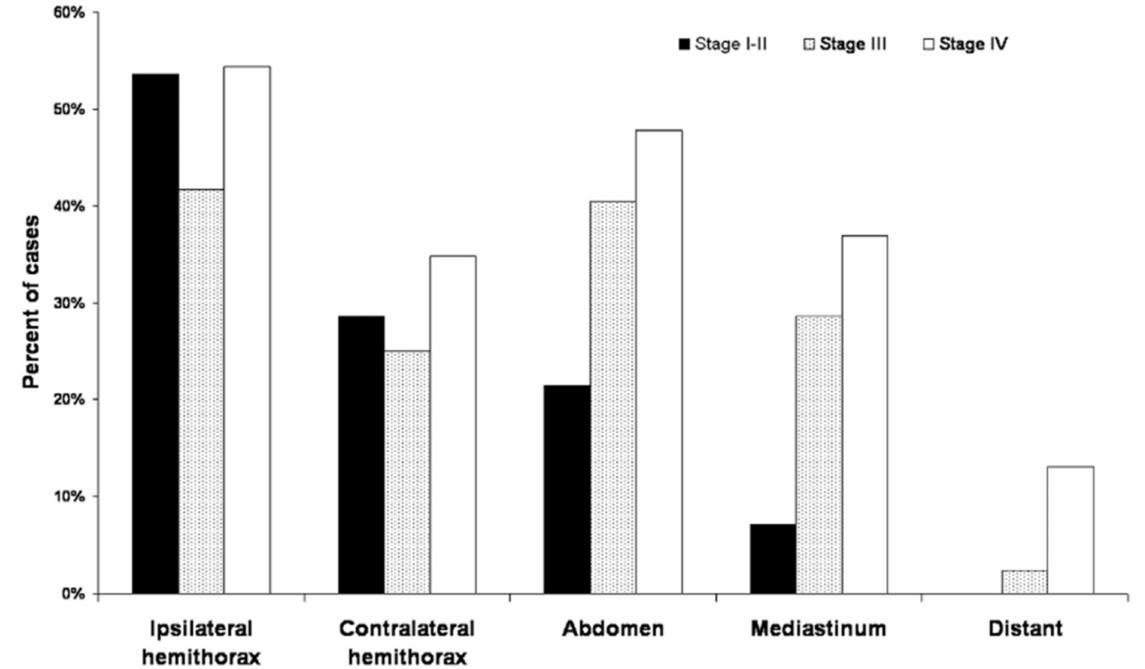
Figure 2. Pattern of first recurrence sites in post-EPP patients ( n = 158) based on the American Joint Committee on Cancer stage. Adapted from ref [87]. Copyright 2015 The American Association for Thoracic